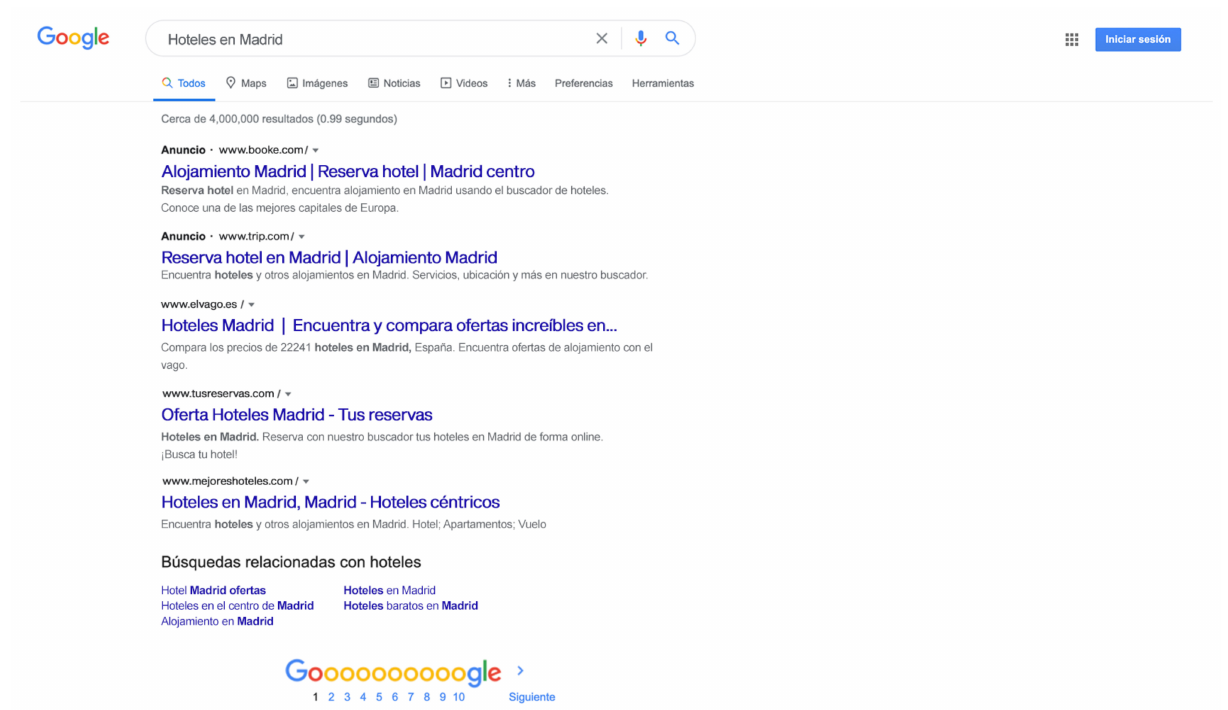
Figure 1. No orientation condition (ASO or neutral).